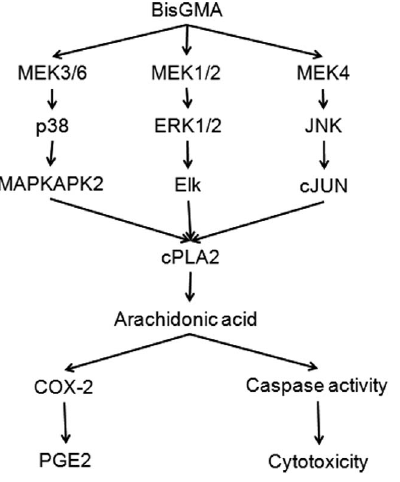
Figure 10. Schematic diagram illustrating the signaling path- ways involved in BisGMA-induced PGE2 generation in RAW264.7 macrophages.